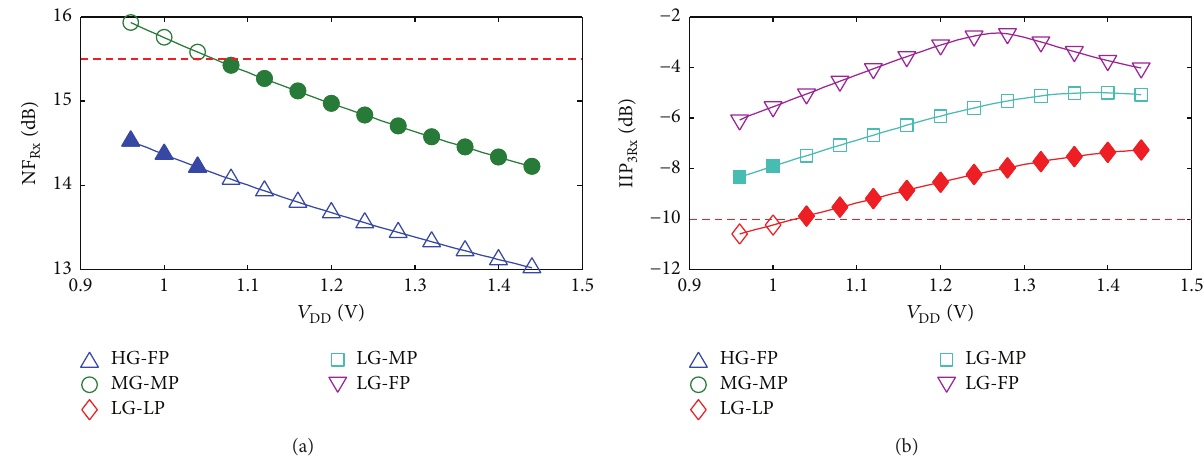
Figure 5: Receiver’s NF (a) and IIP 3 (b) under LNA supply variations.